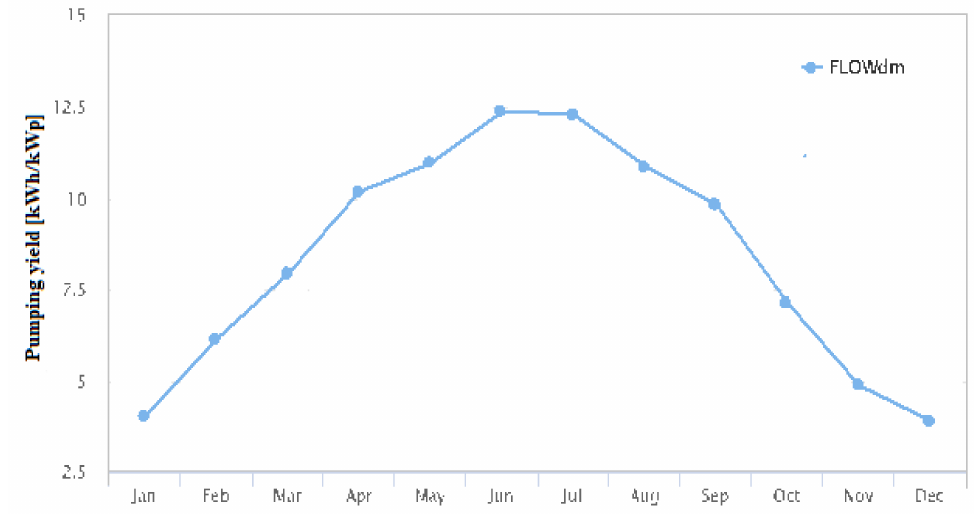
Figure 14. Monthly pumping yield of the PV pumping system (Antalya, Turkey).